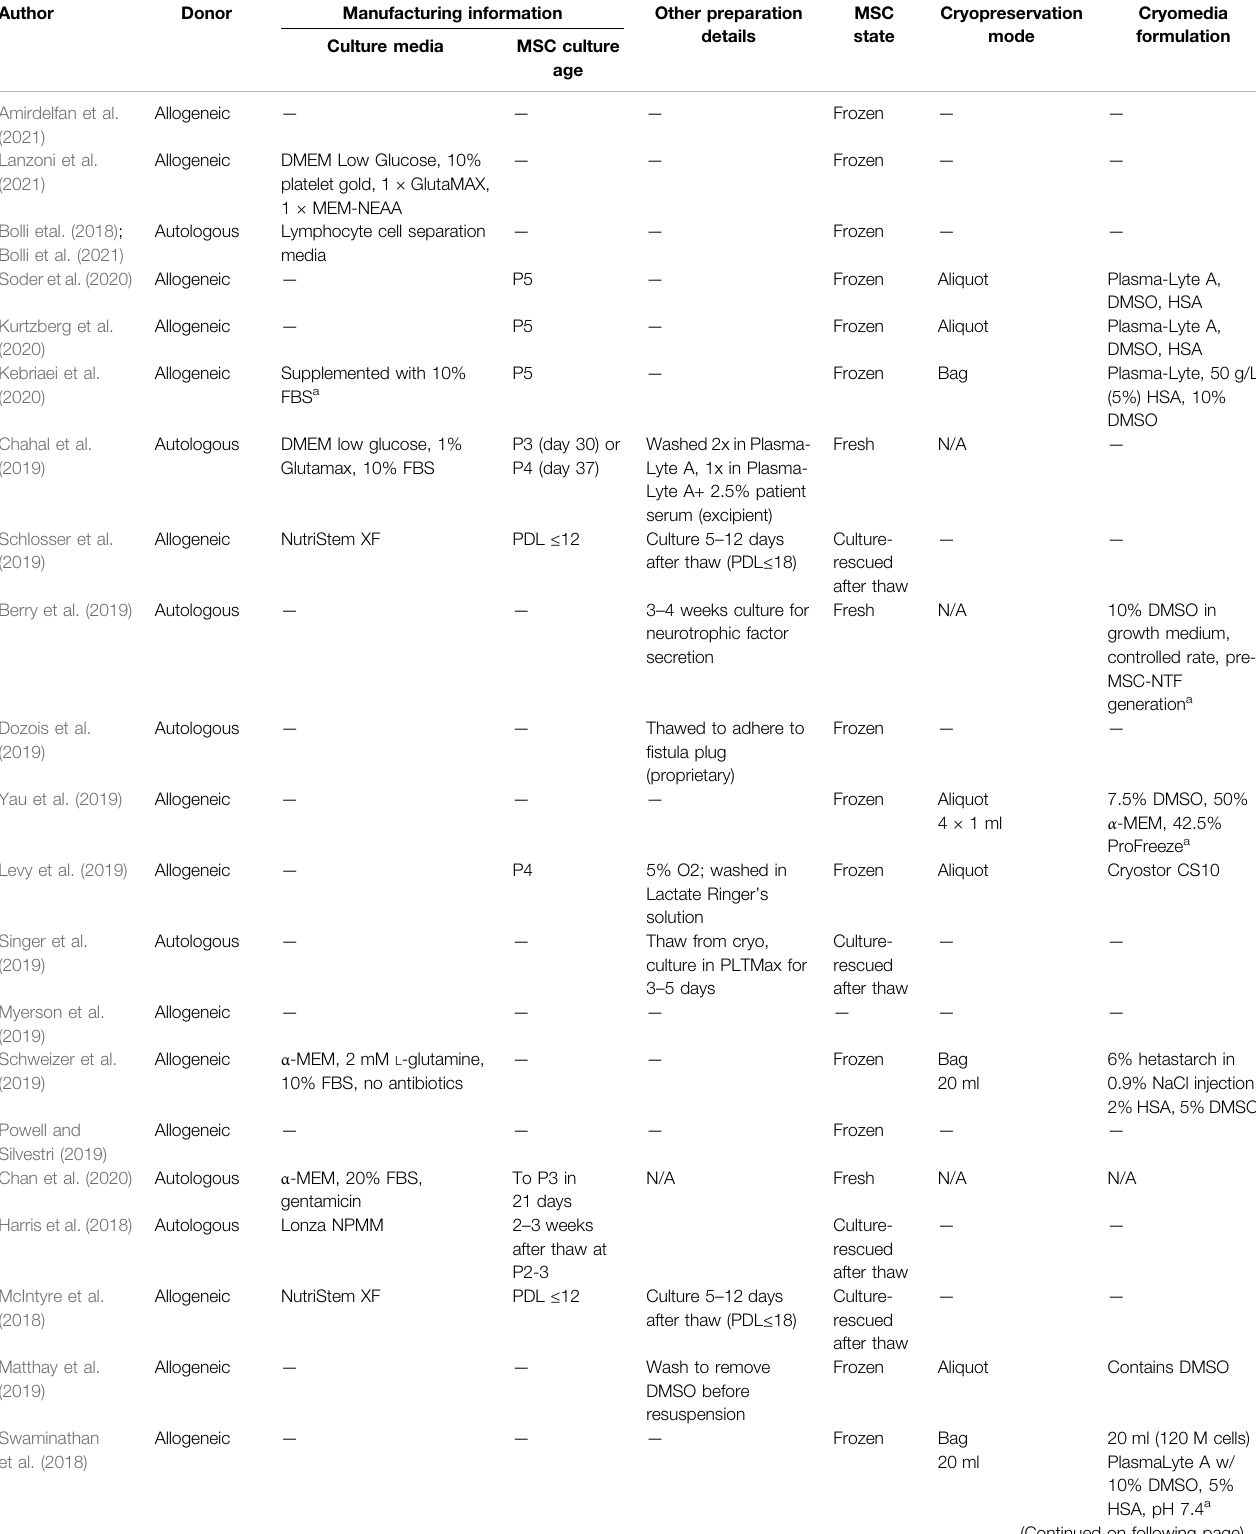
TABLE 2 | Clinical trial publications underreport MSC manufacturing details. Dashed lines represent unreported